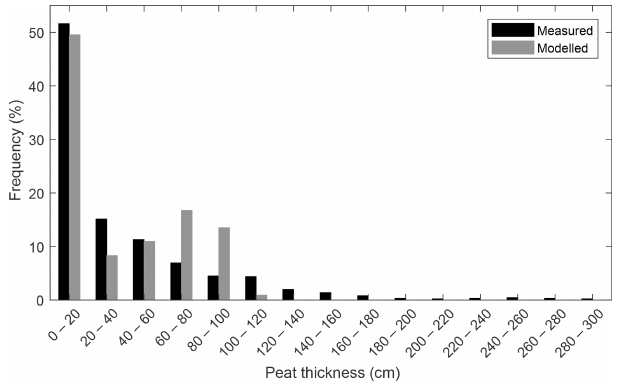
Figure 14. Frequency distribution of the measured and modelled peat thickness for all grid